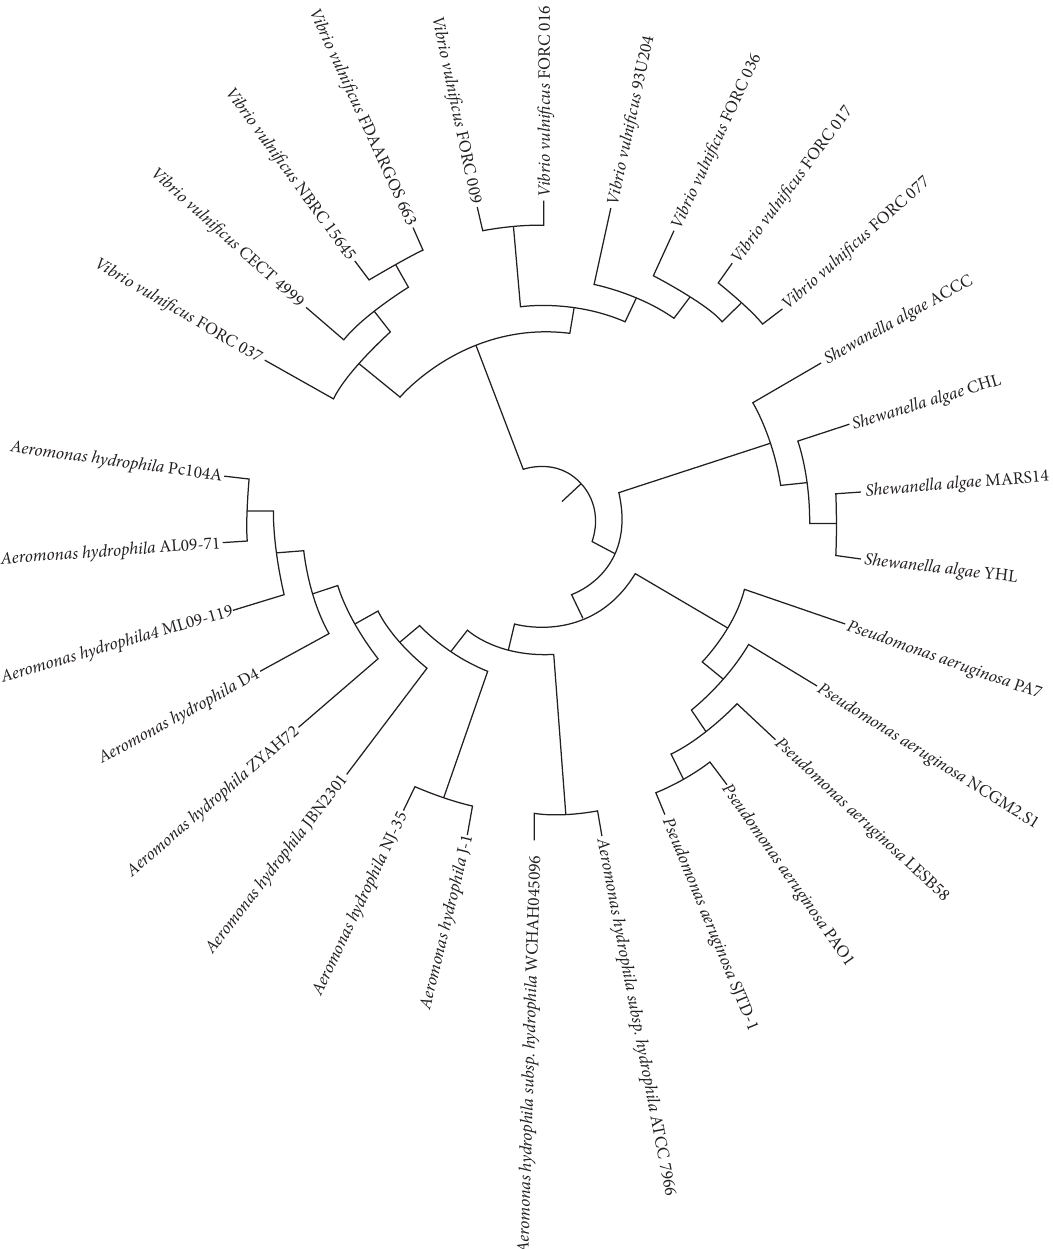
Figure 1: Whole-genome phylogeny of S. algae in the